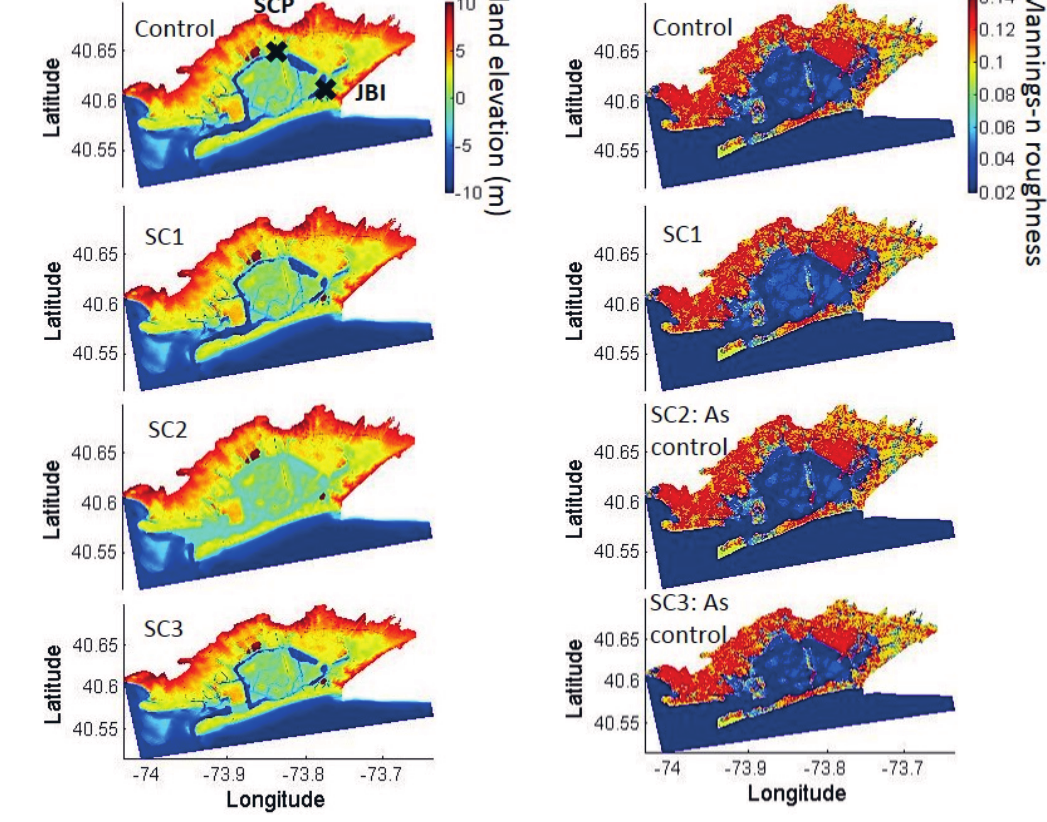
Figure 2. Maps of adaptation scenarios 1–3 and control—Land elevation ( left ) and Mannings- n ( right ). The Spring Creek Park (SCP) and Inwood (JBI) sites are also indicated (X) in the top left panel. Elevations are shown relative the NAVD88